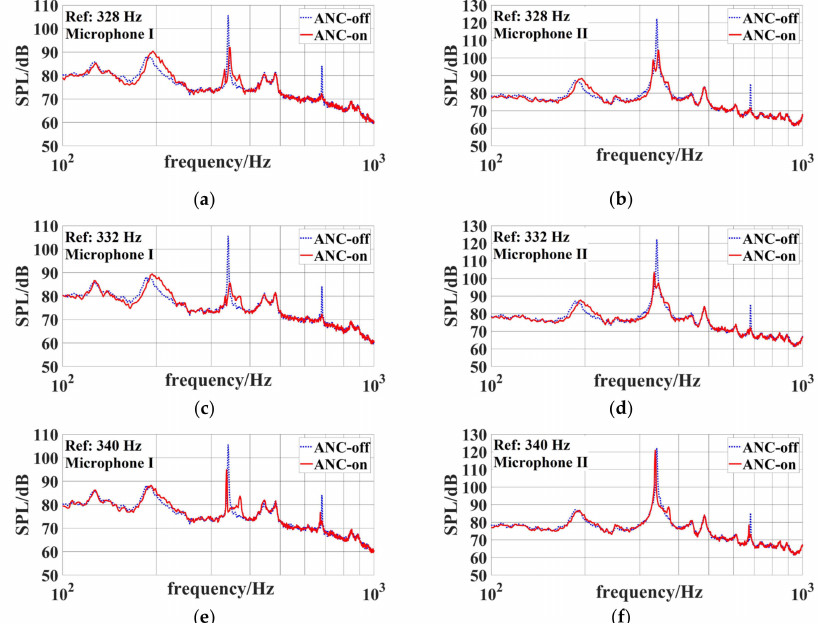
Figure 8. Experimental results with 236 mm cavity: the noise spectrum at the test ( a ) microphone I and ( b ) microphone II with a 328 Hz reference; the noise spectrum at the test ( c ) microphone I and ( d ) microphone II with a 332 Hz reference (best); the noise spectrum at the test ( e ) microphone I and ( f ) microphone II with a 340 Hz (resonance frequency) reference.